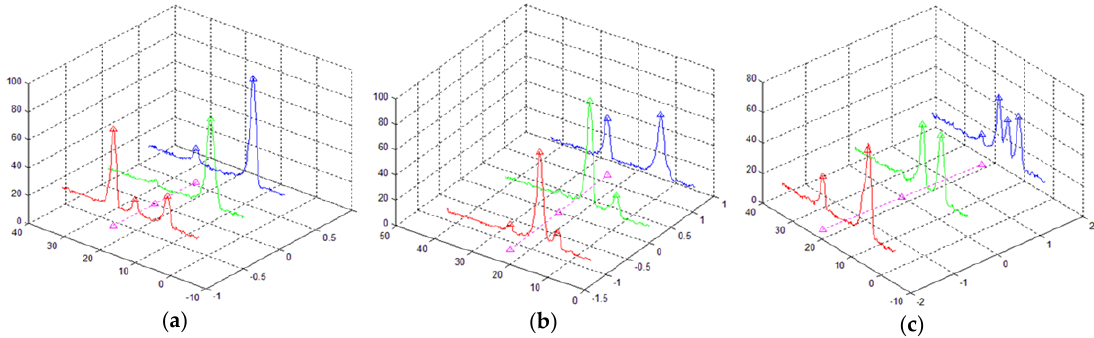
Figure 7. The different spatial distances: ( a ) Distance 1: 0.4–0.7 m; ( b ) Distance 2: 0.7–1.4 m; ( c ) Distance 3: 1.4–2.1 m.